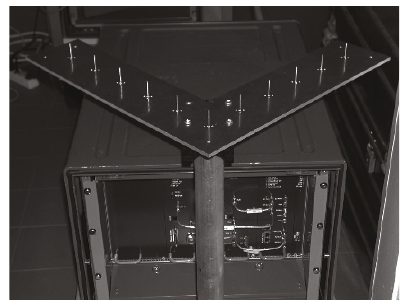
Figure 3: Transmitting antenna